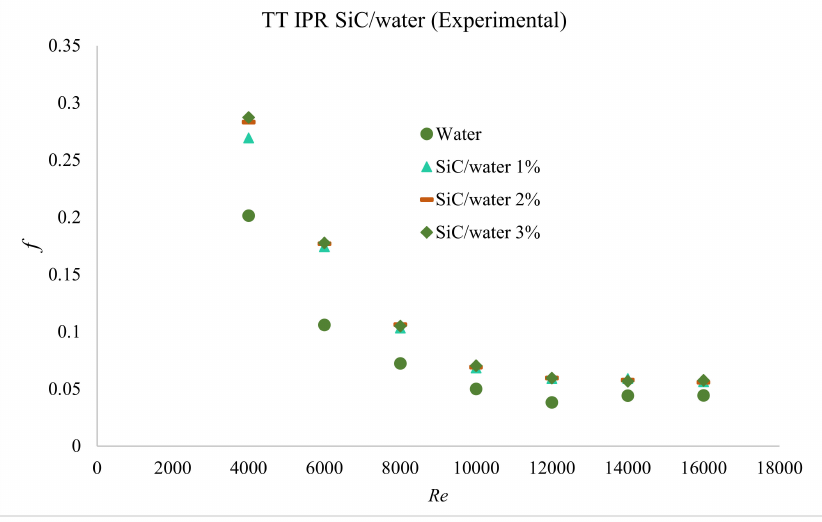
Figure 27. E ff ect of the nanofluid volume fraction ϕ on f